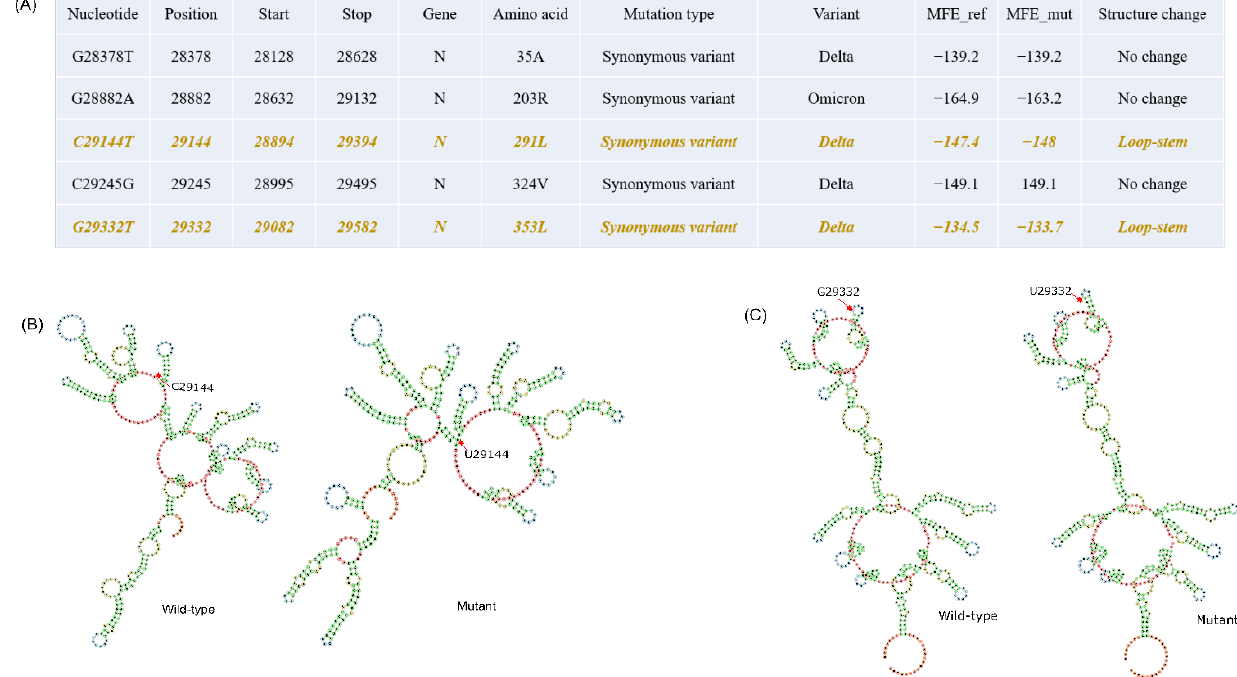
Figure 5. Synonymous mutations in the N gene and their effect on the RNA structural changes. ( A ) Table depicting the synonymous mutations of the N gene with two mutations (Orange color text) reflecting the RNA structure modulation. ( B ) RNA secondary structure of C29144T mutation, the wild type and the mutant with red arrows depicting the site of mutation. ( C ) RNA secondary structure of G29332T mutation, the wild type and the mutant with red arrows depicting the site of mutation.